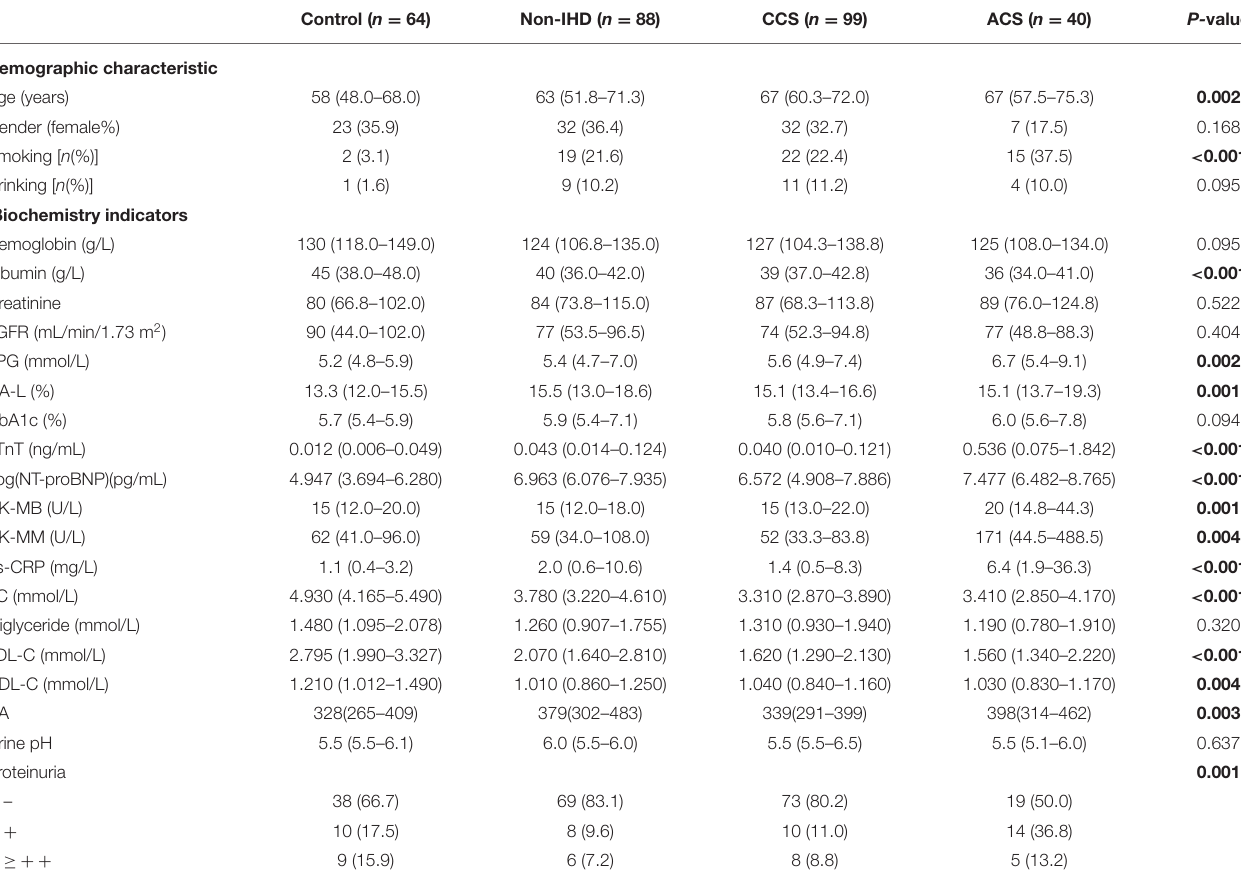
TABLE 1 | Demographic and laboratory information of the study